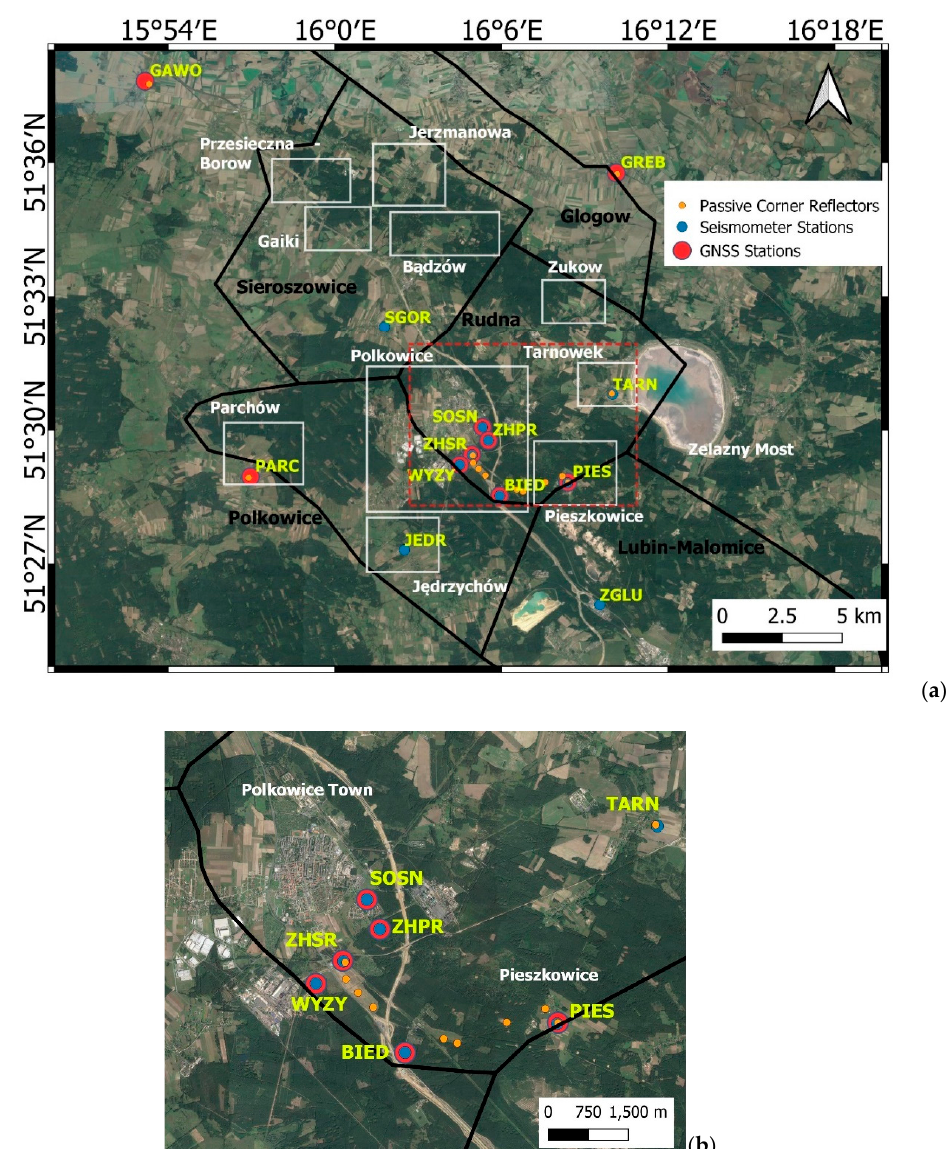
Figure 1. Overview of the area of interest in the Lower Silesian region, Poland ( a ), zoomed in to Polkowice town ( b ). The locations of PCRs are indicated, and the locations and names of the seismometers and GNSS stations. Areas affected by strong deformations are indicated in white; mining areas are indicated in black (from http://dm.pgi.gov.pl/, accessed on 10 March 2022).